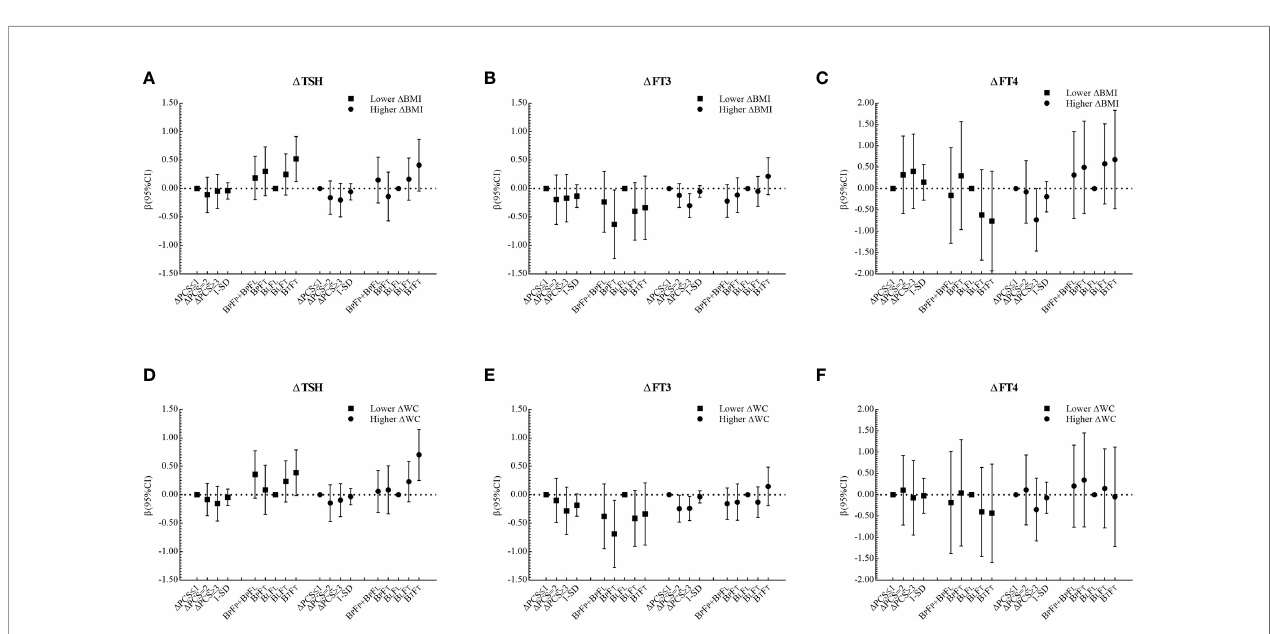
FIGURE 2 | b and 95% con fi dence interval (95% CI) for D THs according to D PCS and puberty pattern by multiple liner regression analyses (Model 2) after being strati fi ed by age at baseline or area with different proportions of iodized-salt consumption.